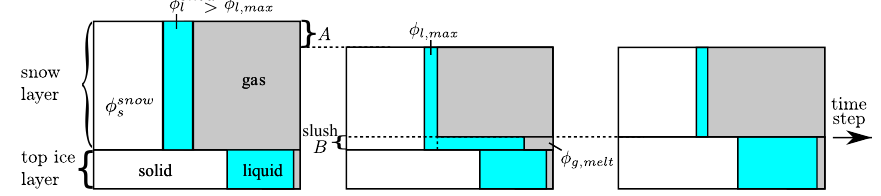
Figure 2. Sketch of snow melt by snow-to-slush conversion as described in Sect. 2.3.1. Snow-to-slush conversion occurs when the liquid fraction exceeds (cid:57) l , max as shown in the left sketch. A slush layer of thickness B is formed, which is instantaneously added to the top ice layer. A is the thickness lost by snow-to-slush conversion. The top ice layer thickness increases by B while the snow layer thickness is reduced by A + B . The white, blue, and grey areas represent the solid, liquid, and gas volume fractions of the model layers. The combined solid and liquid volumes of the snow and top ice layer are conserved during the